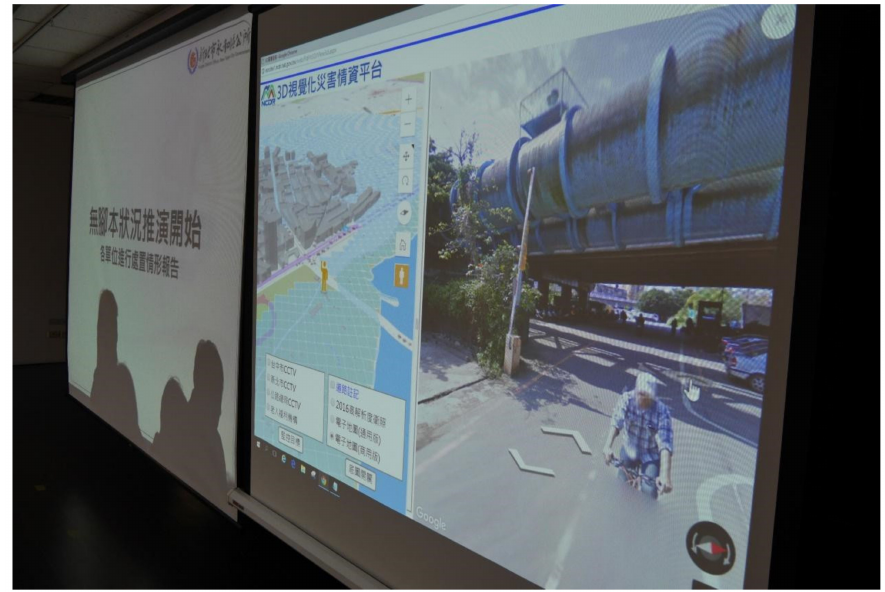
Figure 19. The tap water pipe in Yonghe District. (Photographed by Yong-Jun Lin). In the case of Special Scenario 2, the FWGAP was used to evaluate the number of affected people (see the image to the left in Figure 19). The location and street view of a care center for the elderly was examined accordingly (central image in Figure 20 marked in green with the associated symbol). Using the street view function, the response team determined that this center was located on the second floor (in the image to the right in Figure 20). Elderly residents who required electricity for life support systems could be transported in high-chassis vehicles or boats across the floodwater and then transported by ambulance. If a CCTV was located nearby, the team could monitor its footage in real time to ascertain the flooding status and implement appropriate measures.